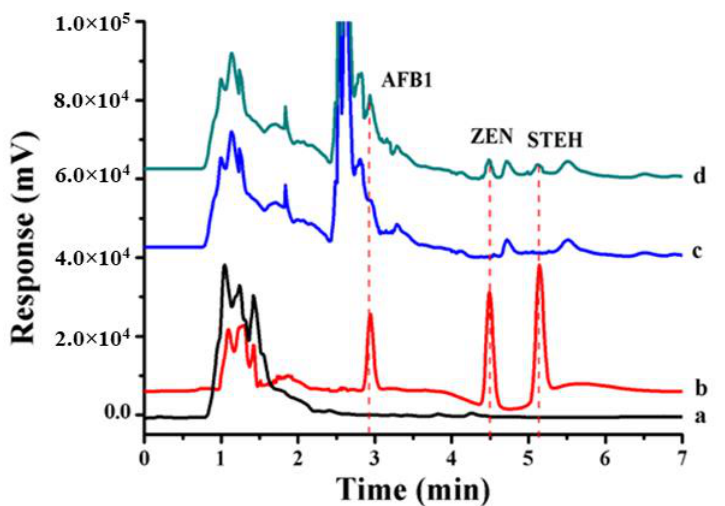
Figure 8. Chromatograms of three mycotoxins obtained from spiked rice grain samples: ( a ) blank sample by in-tube SPME-HPLC method; ( b ) in-tube SPME–HPLC from spiked rice grain sample; ( c ) direct injection mode of HPLC of the blank rice grain sample; ( d ) direct injection mode of HPLC of the spiked rice grain sample. The analytes of three mycotoxins were spiked respective at 0.1 mg/Kg, the volume for direct injection was 20 μL. (Reprinted with permission from reference [79]).